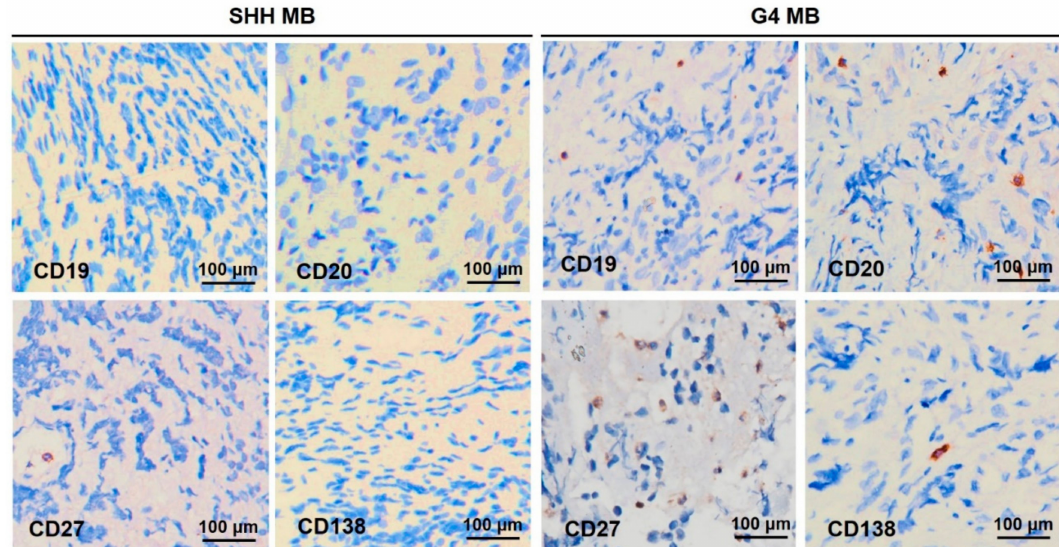
Figure 7. Representative photomicrographs of TIL-B subsets in patients with the SHH or G4 MB. IHC using primary antibodies against CD19, CD20, CD27, and CD138 to characterize TIL-B subsets in tumor tissue (original magnification,400 ×